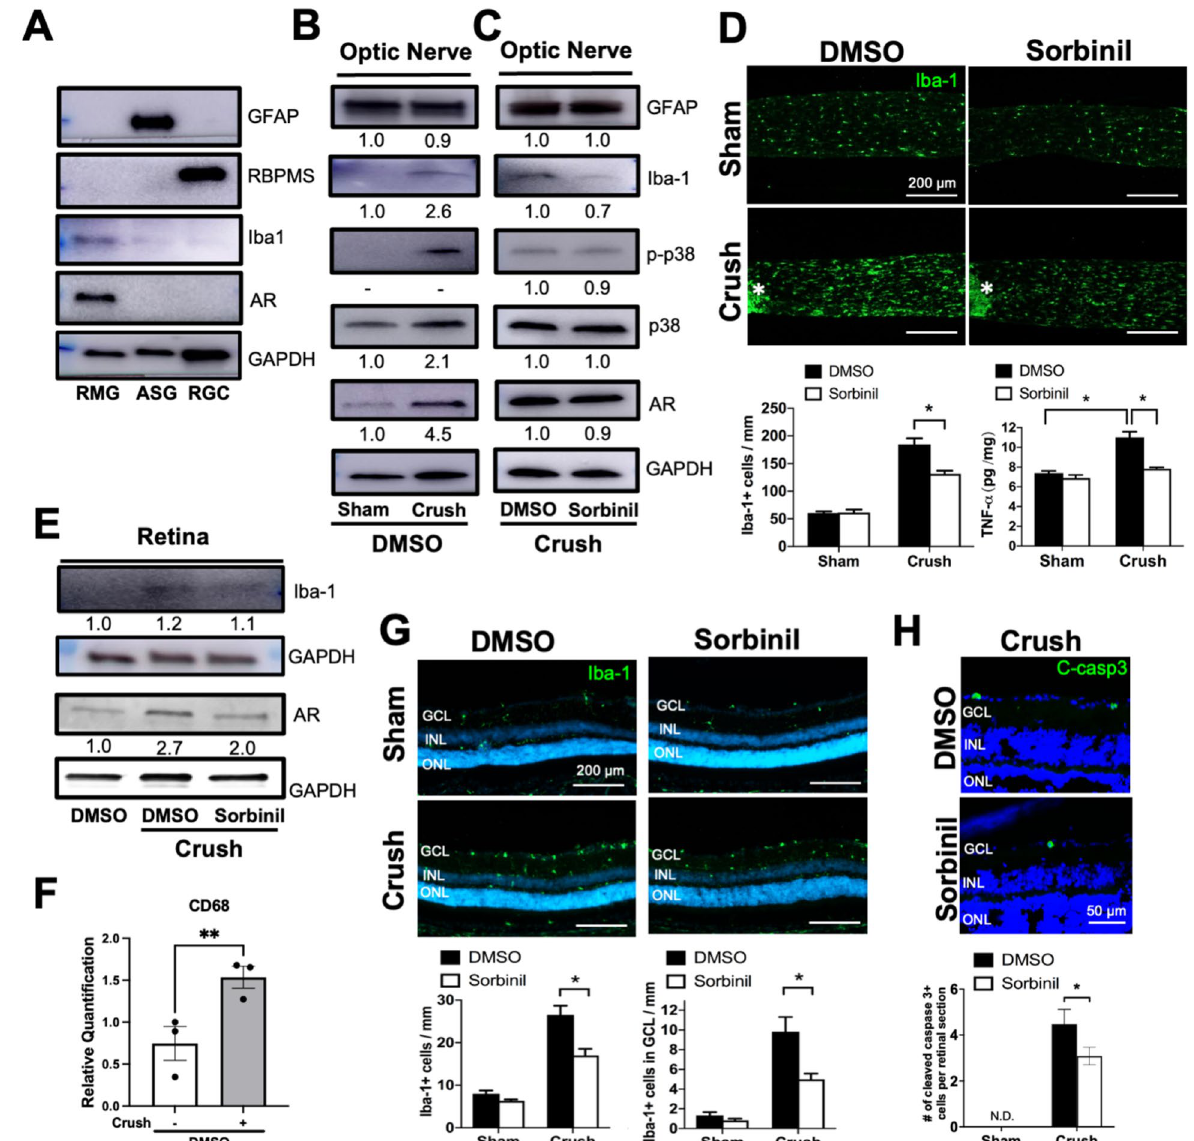
Figure 2. Sorbinil alleviates RMG activation in the retina and optic nerve after ONC. (A) AR is highly expressed in RMG compared to ASG and RGC. (B) ONC increases AR and Iba1 protein expression in the ON compared to noncrush (sham) control group. Sorbinil treatment reduces ONC-induced AR and Iba1 protein expression in the ON (C) and retina (E). Sorbinil treatment attenuates RMG distribution and TNF-α secretion in the ON (D) and retina (F). Asterisk in (D) marks the crush site. (G) ONC triggers microglial activation as measured by CD68 gene expression (H) Sorbinil treatment reduces the number of cleaved caspase-3 positive cells in the ganglion cell layer (GCL) of the ONC retina, indicating reduced apoptotic cell death. N.D. refers to no detection of Cleaved caspase-3 signal. (N ≥ 3 per group. Statistical significance was determined using one- way ANOVA and post hoc t-test with Tukey correction (*P < 0.05). Mean ± SEM is